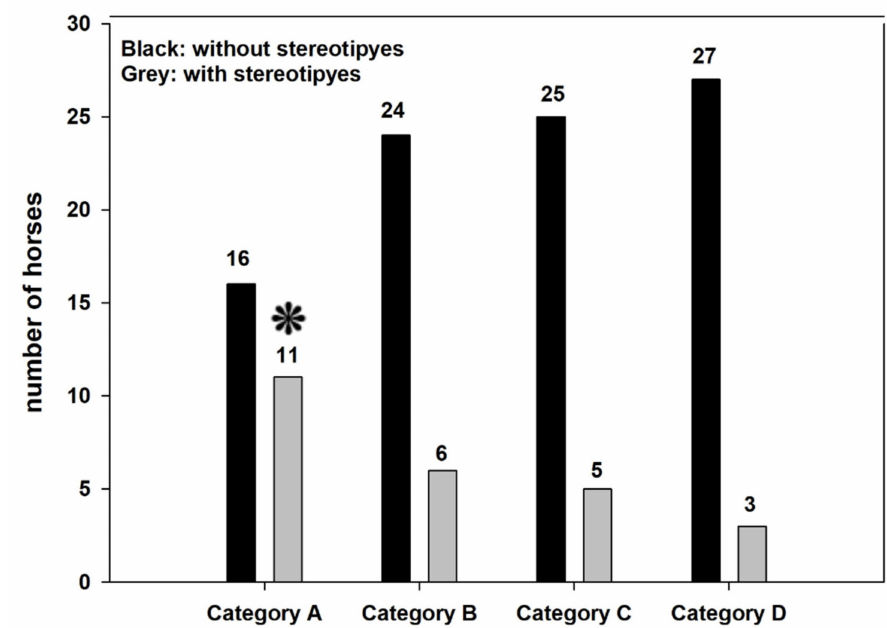
Figure 1. Distribution of horses with and without stereotypes in the various housing conditions. * means p <